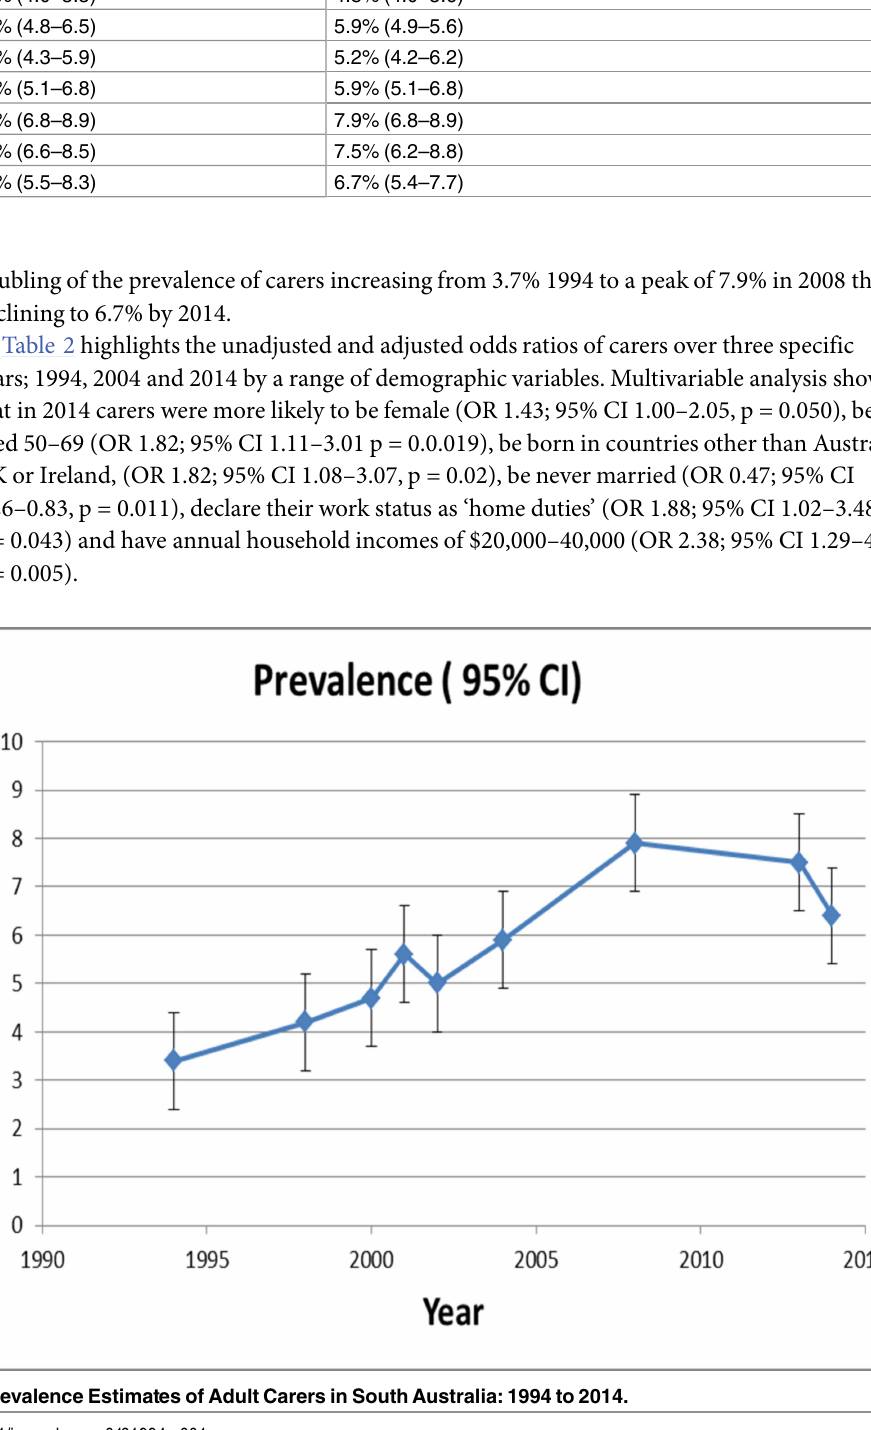
Fig 1. Prevalence Estimates of AdultCarers in SouthAustralia:1994 to